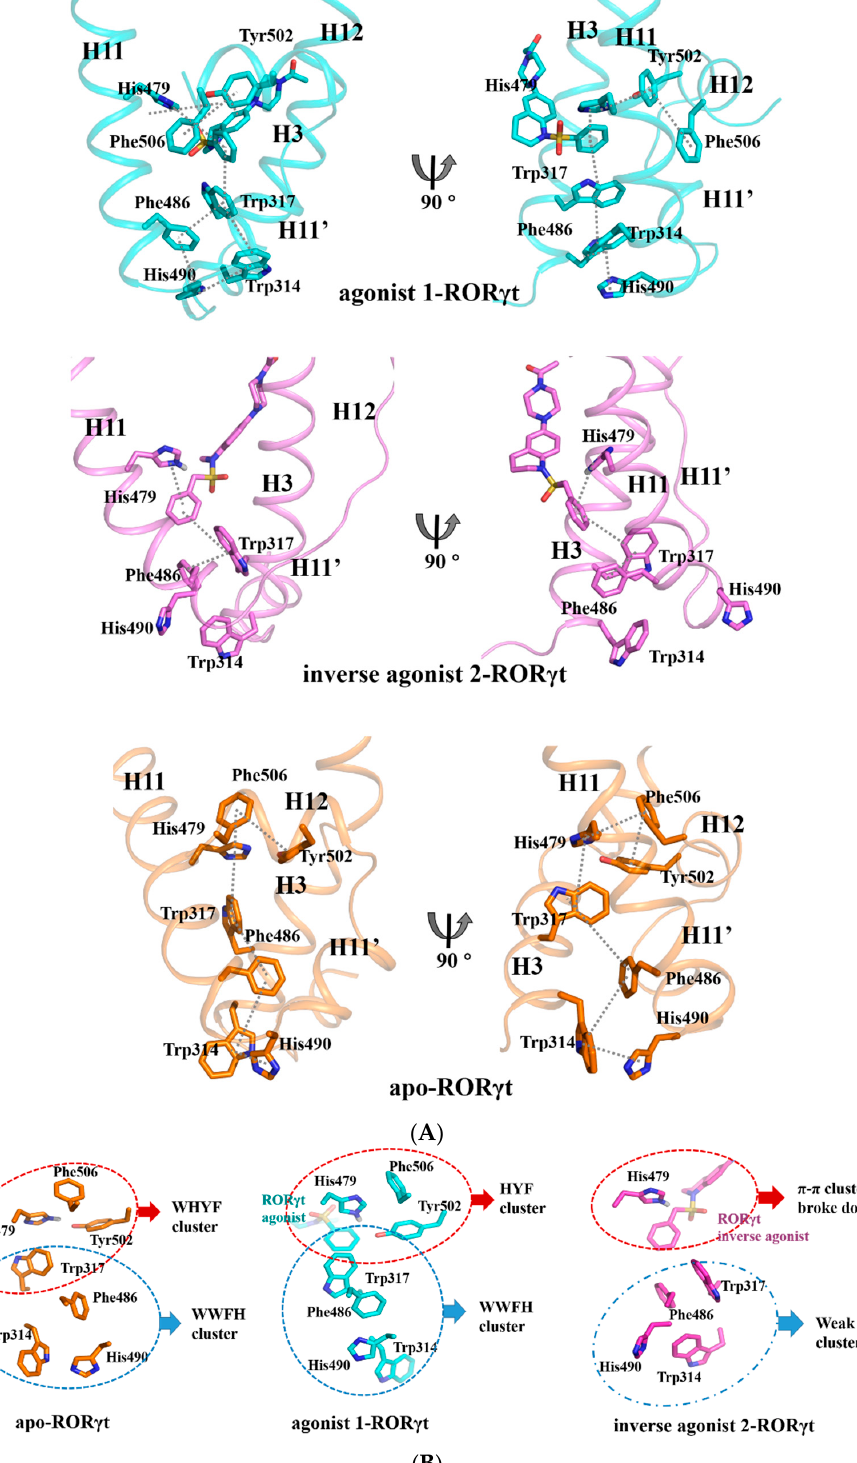
Figure 5. The hydrophobic network mediated by Trp317 in the agonist-bound, and apo ROR γ t, but partially destroyed in the inverse agonist-bound ROR γ t. ( A ) π - π cluster interactions between Phe506, Tyr502, His479, Trp317, Phe486, His490, and Trp314 in apo-, agonist-, and inverse agonist-ROR γ t system. ( B ) Hydrophobic network between H11, H11 ′ , and H12. Apo-ROR γ t shown in orange, agonist 1 -ROR γ t shown in blue and inverse agonist 2 -ROR γ t shown in magenta.